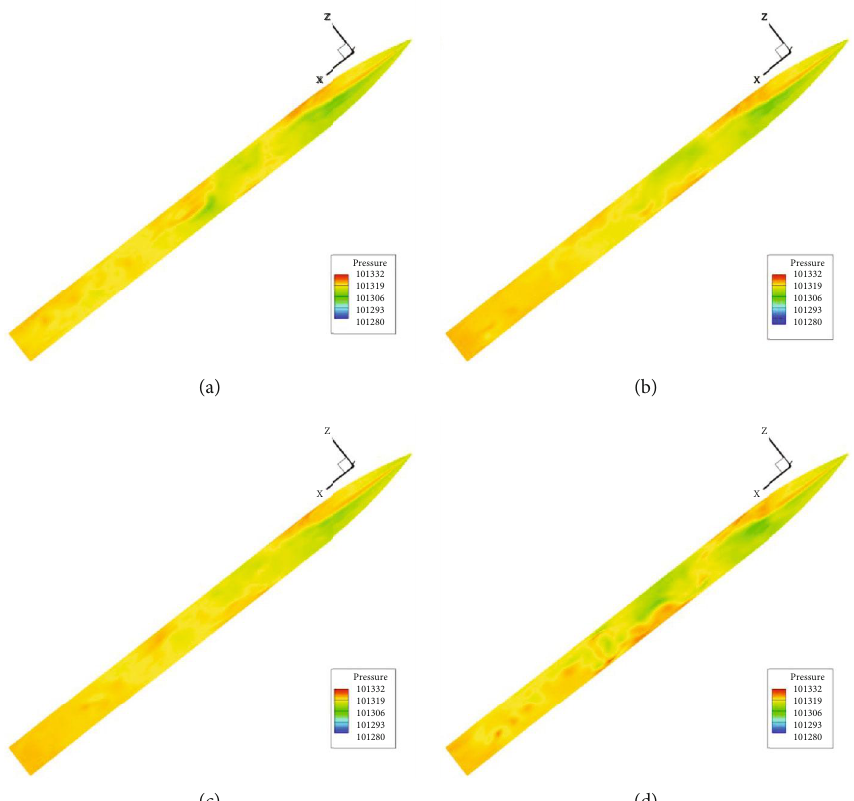
Figure 30: Comparison of leeward pressure with di ff erent roughness values: (a) Model 1, (b) Model 2, (c) Model 3, and (d) Model